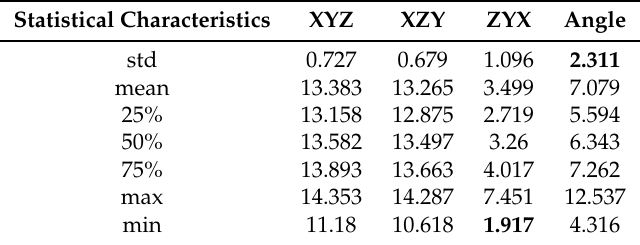
Table 4. Statistical data evaluation for Elongation at break for each orientation separately.